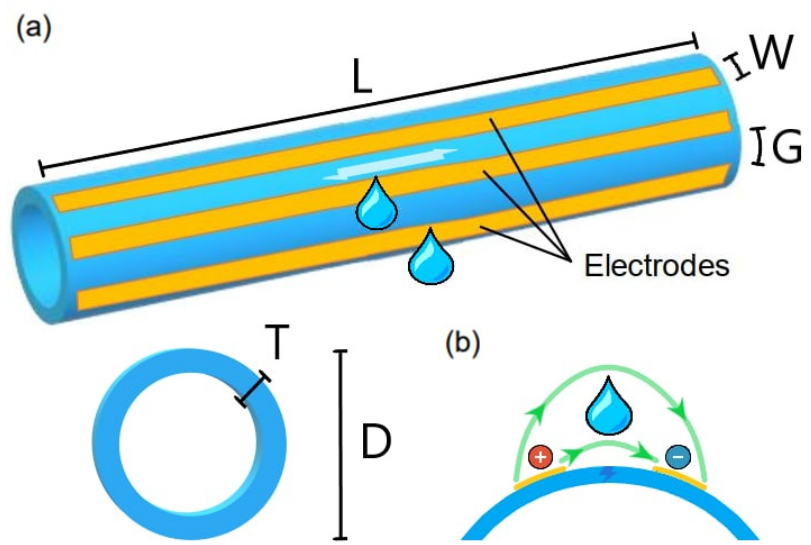
Figure 1. ( a ) Sensor’s geometrical parameters. ( b ) The electric field (in green) set between adjacent electrodes senses any alteration in the outer medium electrical properties, e.g., due to a water